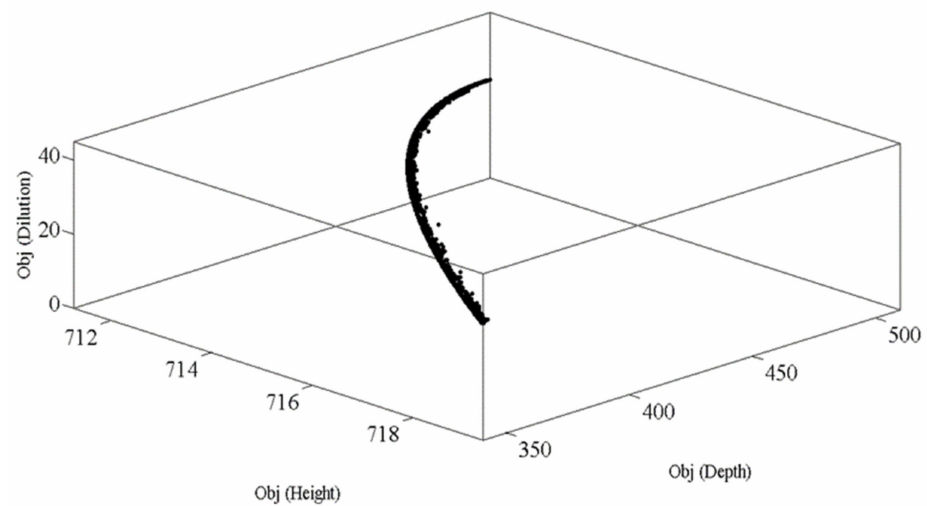
Figure 15. 3D Pareto frontier of the three objective functions including depth, dilution, and height of clads, with a feed rate of 15 g/min and without pre-heating.